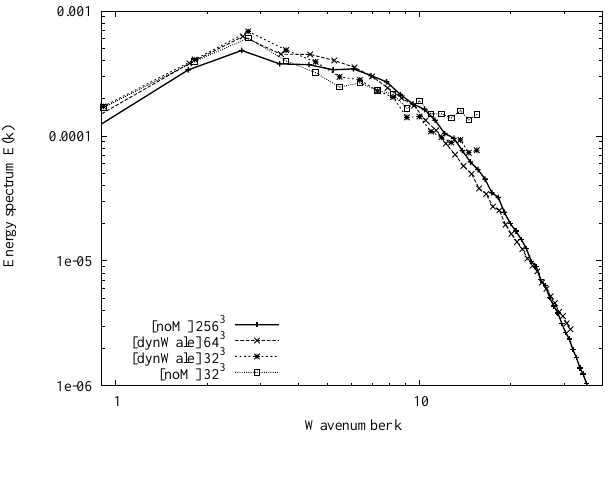
Figure 5. Energy spectrum E (k) at t/τ e = 5 . 465 obtained with different spatial resolutions and with/without subgrid-scale LES